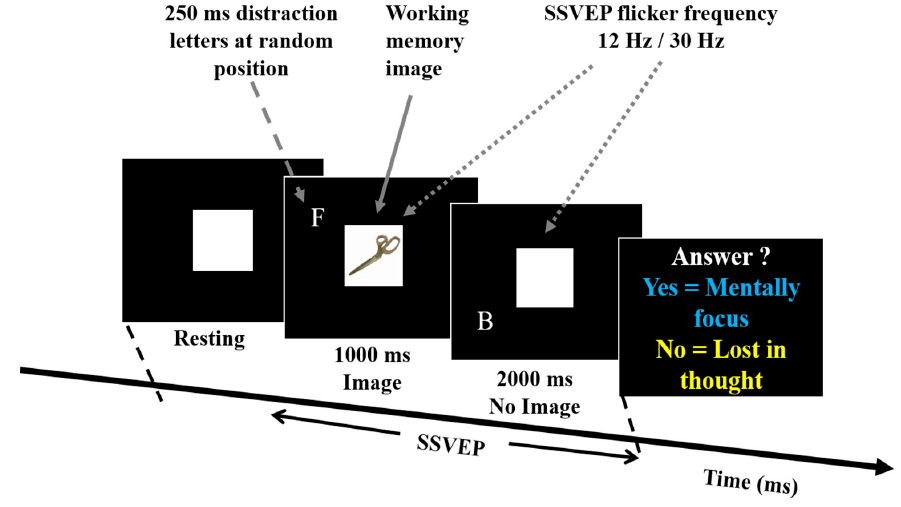
Figure 1. Experimental setup used for steady-state visual evoked potential (SSVEP), working memory, and distraction tasks. In this experiment working memory images, SSVEP flashing frequencies at 12 Hz and 30 Hz, and distraction letters were used as stimuli. In this scenario, all participants were instructed to look at the center of the screen and perform SSVEP-BCI task. This experiment was designed to recognize the brain dynamics of mental focus and lost-in-thought states.